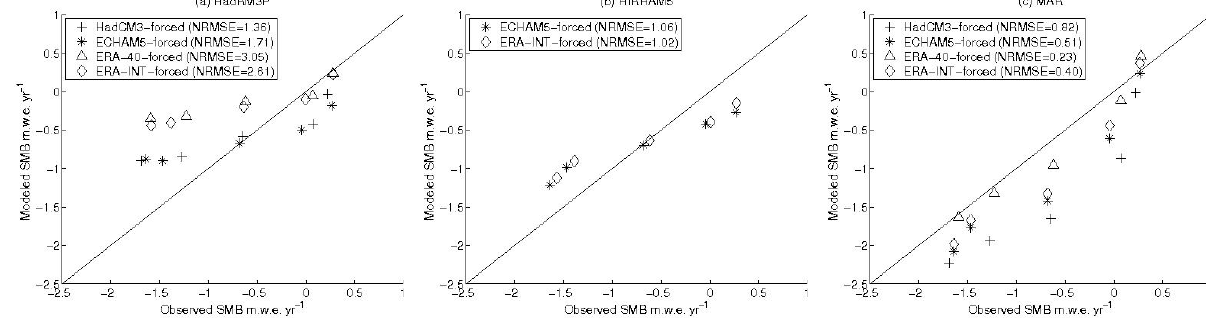
Fig. 9. Simulated and observed SMB averaged over periods where data is available. (a) HadRM3P, (b) HIRHAM5, (c)